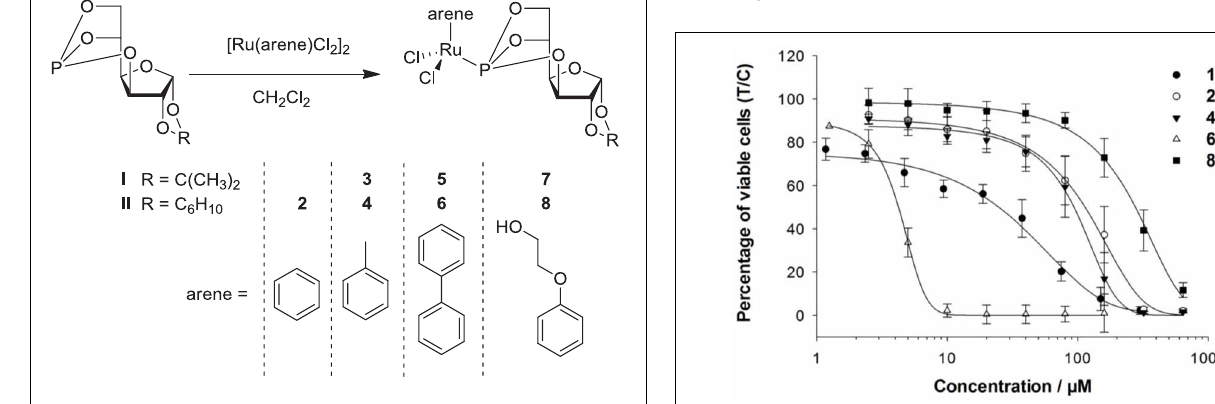
FIGURE 3 | Concentration–effect curves of 1b, 2, 4, 6, and 8 in CH1